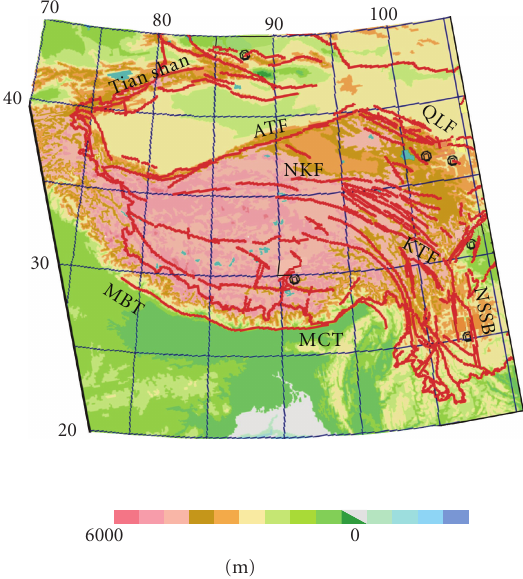
Figure 1: Topographic and tectonic map of the Tibetan Plateau and surrounding regions. Solid lines show major faults (ATF: Altyn Tagh Fault; NKF: North Kunlun Fault; KTF: Kang Ding Fault; MCT: Main Central Thrust; MBT: Main Boundary Thrust; QLF: Qilian fault). NSSB: southern segment of the North-South Seismic